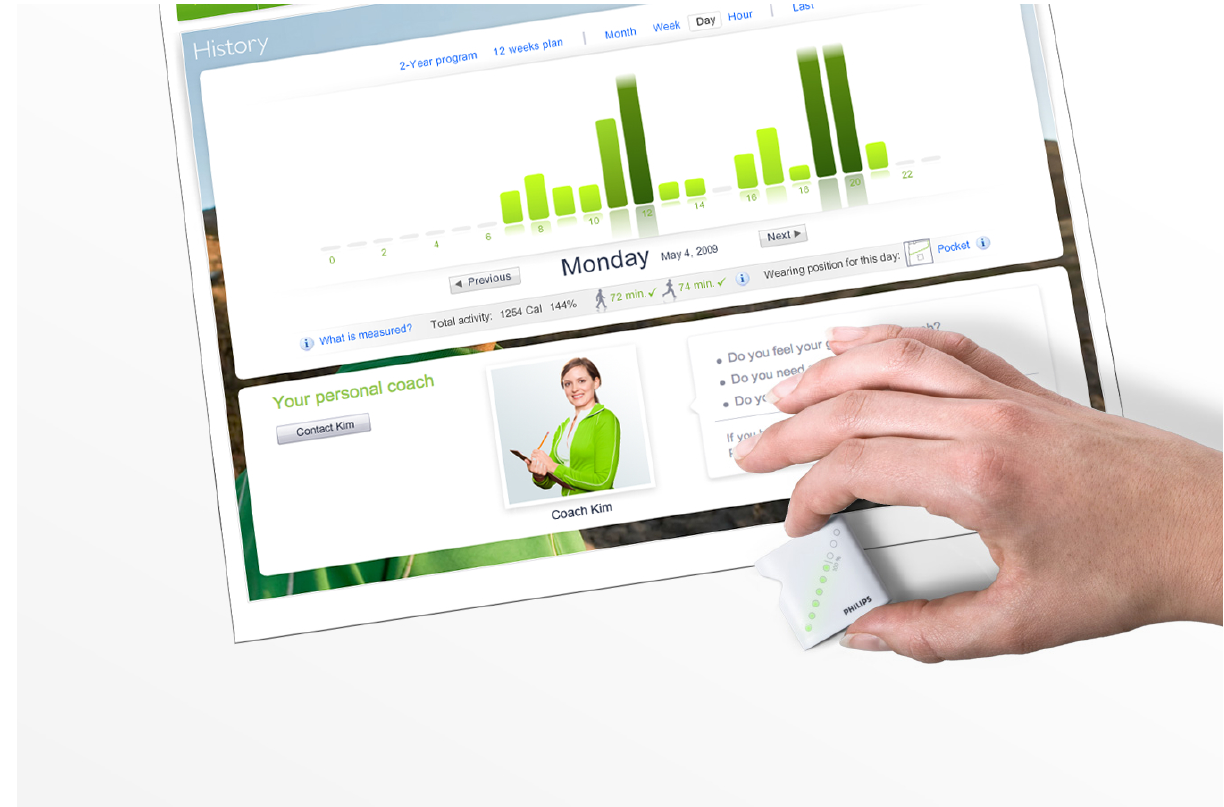
Figure 1. Screenshot of DirectLife intervention program and